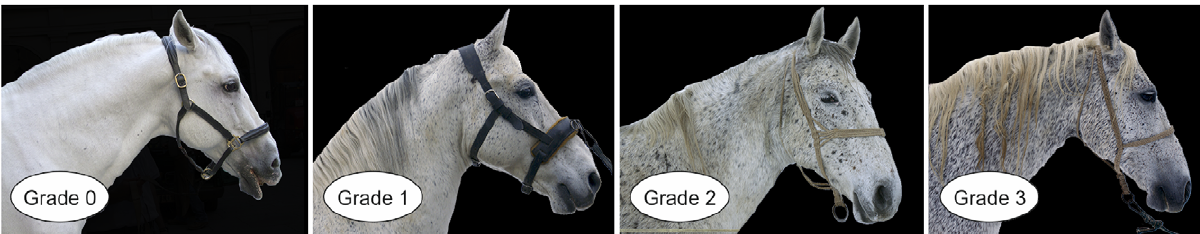
Figure 5. Variation of speckling grade in four grey Lipizzan horses.